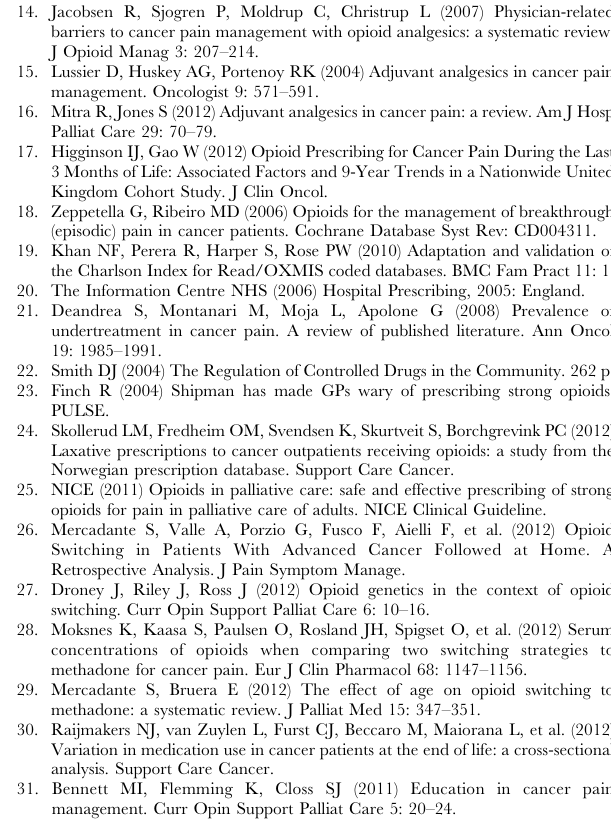
Table S1 Crude prevalence ratios (CPR, 95%CI) and adjusted prevalence ratios (APR, 95%CI)* of factors